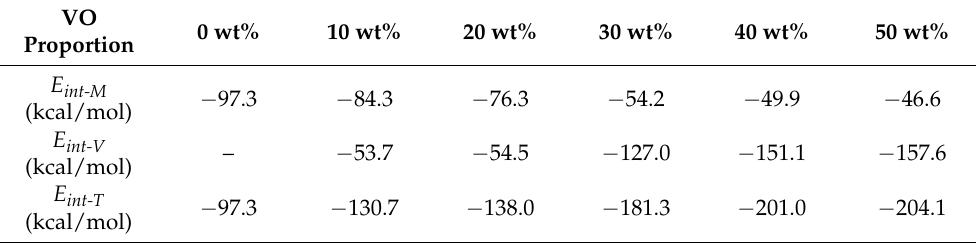
Table 11. Interaction energy between mixed oil and water molecules with 1 wt% of water content. VO